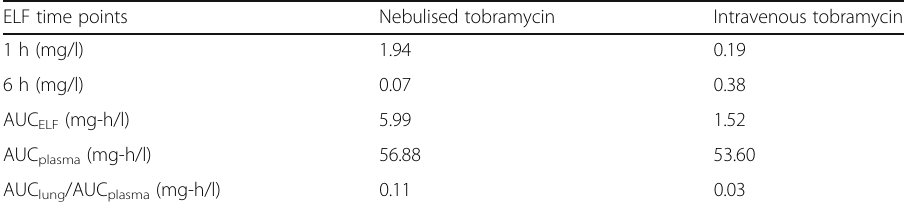
ELF epithelial lining fluid; AUC area under the concentration-time